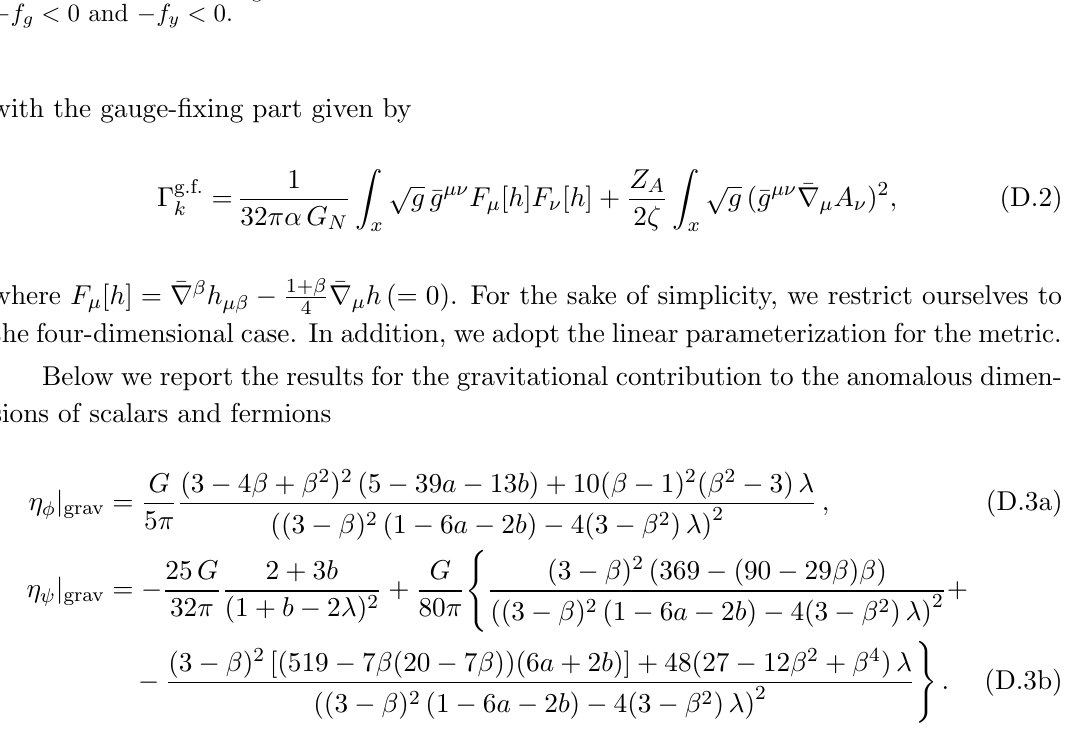
JHEP09(2019)100